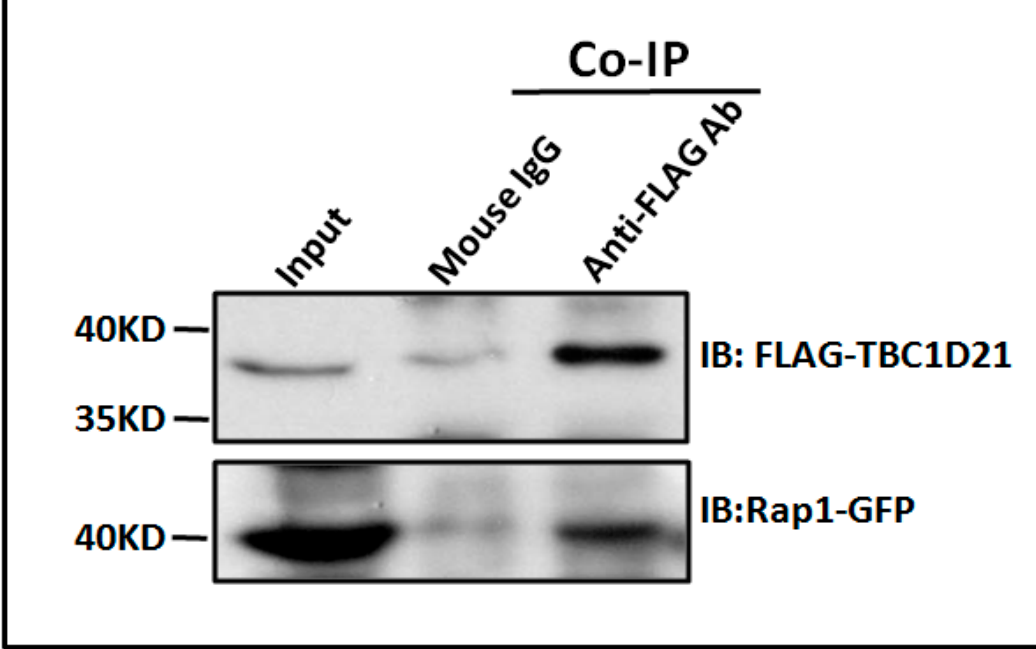
Figure 2. TBC1D21 interacts and with Rap1. The co-IP of FLAG-TBC1D21 with Rap1-GFP. The lysates of NTERA-2 cl.D1 (NT2D1) cells transfected with pEGFP-Rap1, and a pFLAG-TBC1D21 vector was subjected to immunoprecipitation with an anti-FLAG antibody (Lane 3) or a nonspecific control IgG (Lane 2), followed by IB with the anti-FLAG antibody (top panel) or anti-Green fluorescent protein (GFP)antibody (bottom panel). An input protein (5%; Lane 1) was used as a control during IB.